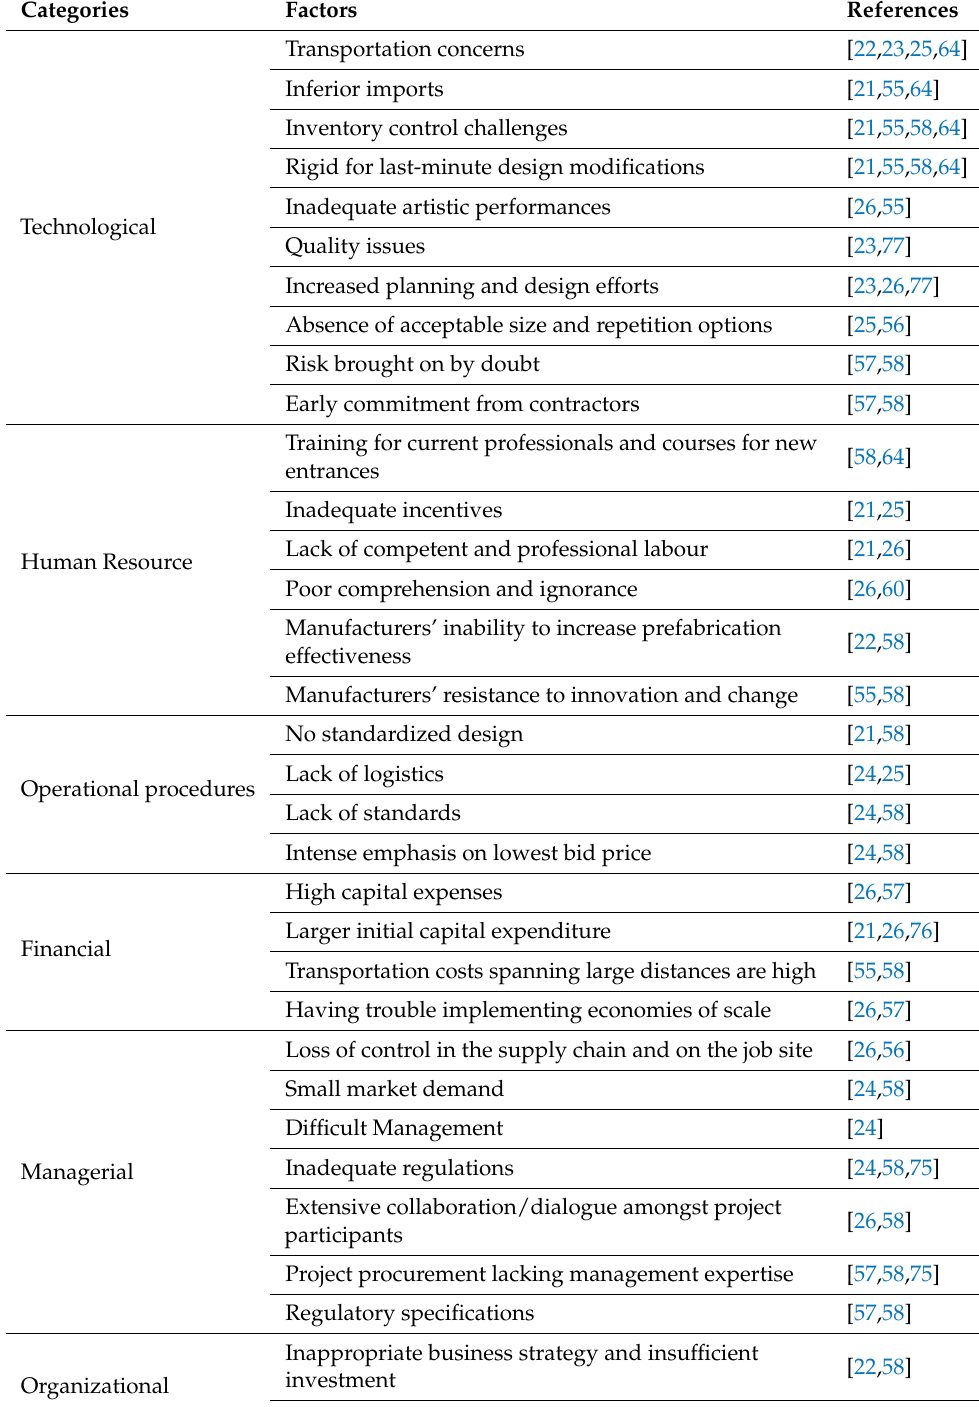
Table 2. Modular Offsite Construction